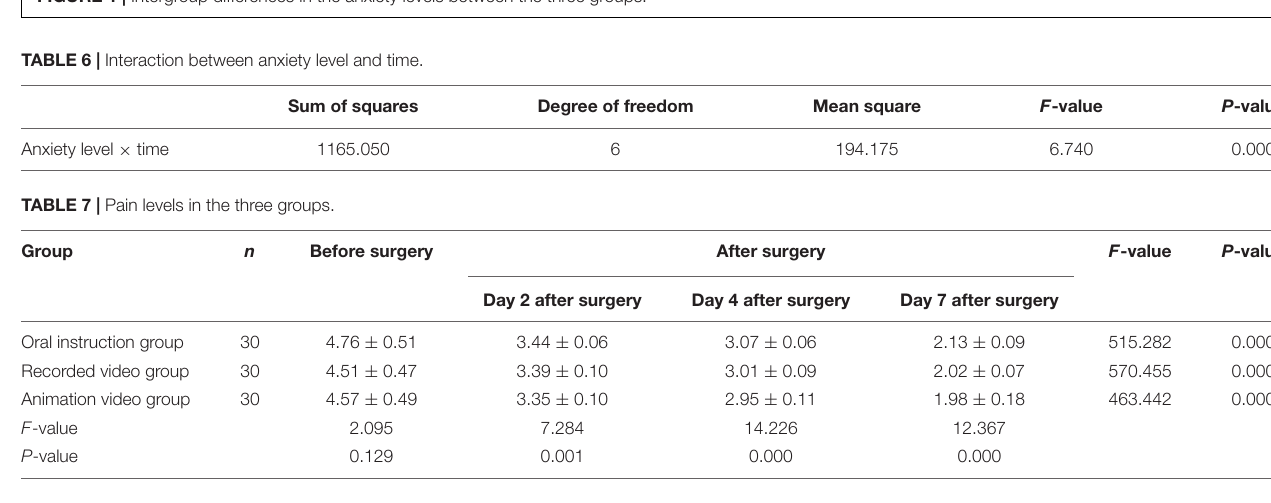
FIGURE 1 | Intergroup differences in the anxiety levels between the three groups.